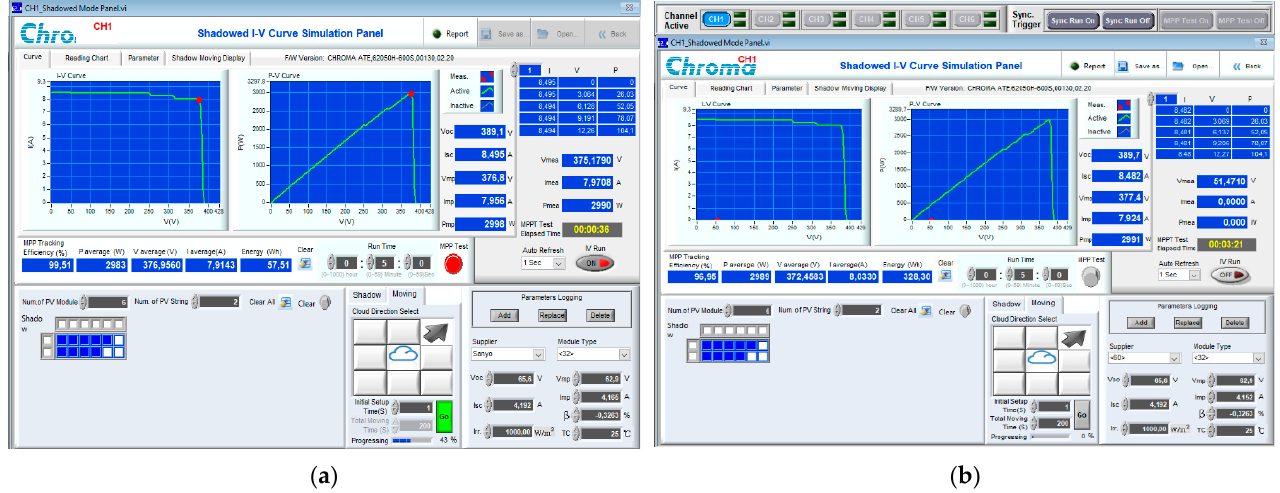
Figure 15. EKF MPPT test of two − phase IBC with 3 kW load: ( a ) partial shading and global MPPT tracking; ( b ) overall MPPT tracking efficiency.